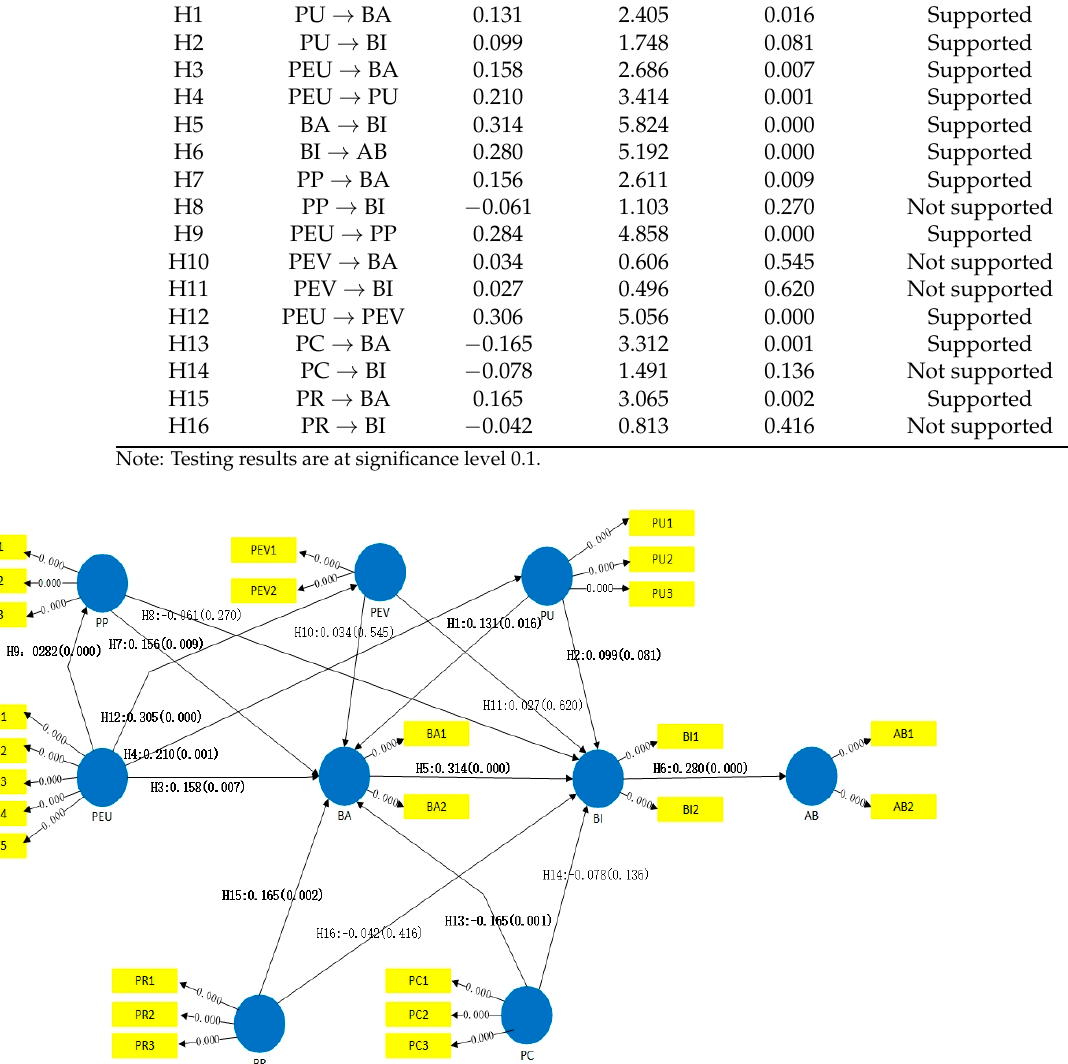
Table 9. Hypotheses testing results.